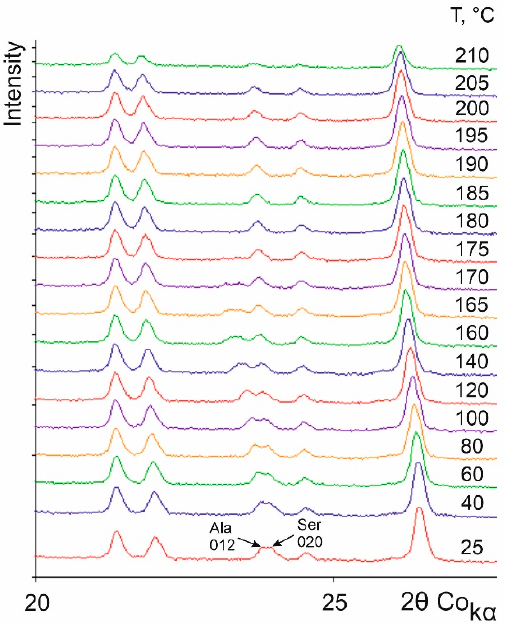
Figure 7. Fragments of the X-ray pattern (2 θ Co K α = 20–28°) of a sample with the L-ser/L-ala ratio of 90/10 registered at different temperatures.